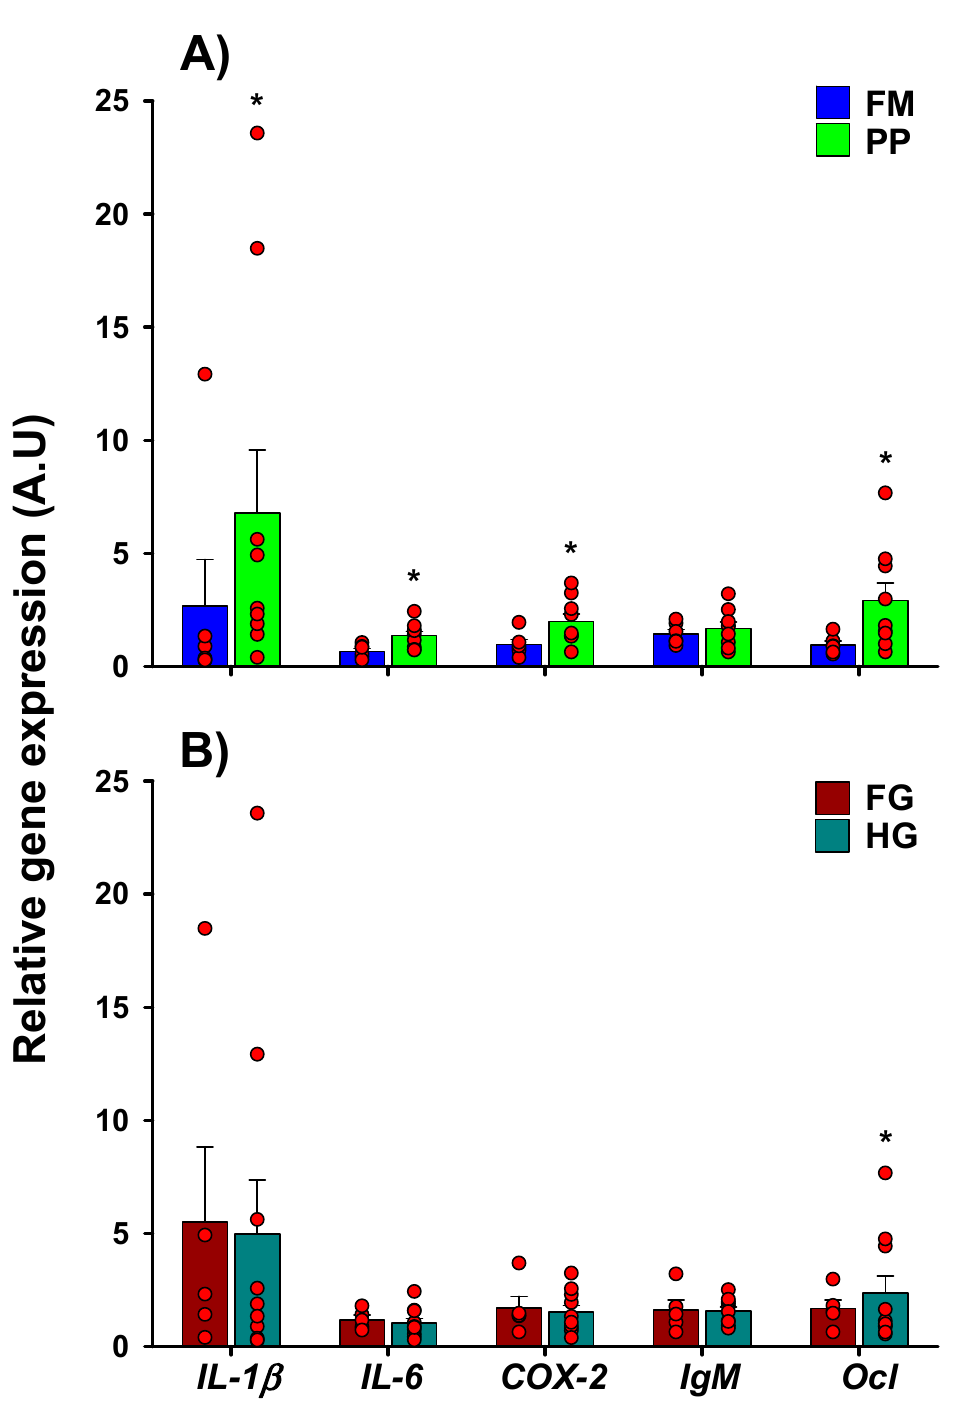
Figure 2. The effect of diet and intestinal section after 6 h of ex vivo bacterial exposition in Phase I (68 g). Relative gene expression (A.U.) of the different genes is expressed by the mean and standard error. Asterisks on the bars indicate significant differences between different conditions (diet/section) for each gene ( p < 0.05) at 6 h of incubation. ( A ) Effect of dietary treatment ( B ) Effect of intestinal section. Sample data in each experimental group are represented by red spots. Foregut (FG); Hindgut (HD).